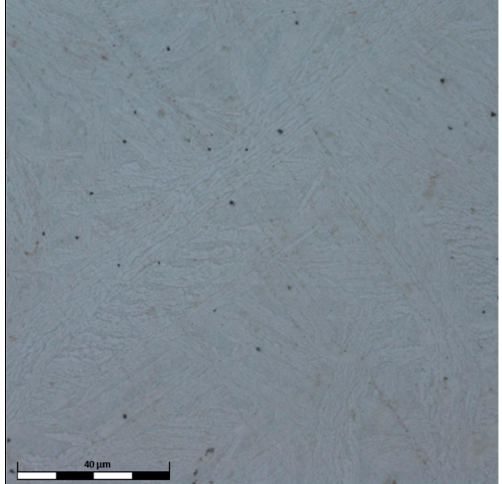
Figure 9. Confocal image of the Al 0.7 CoCrFeNi surface after corrosion test.